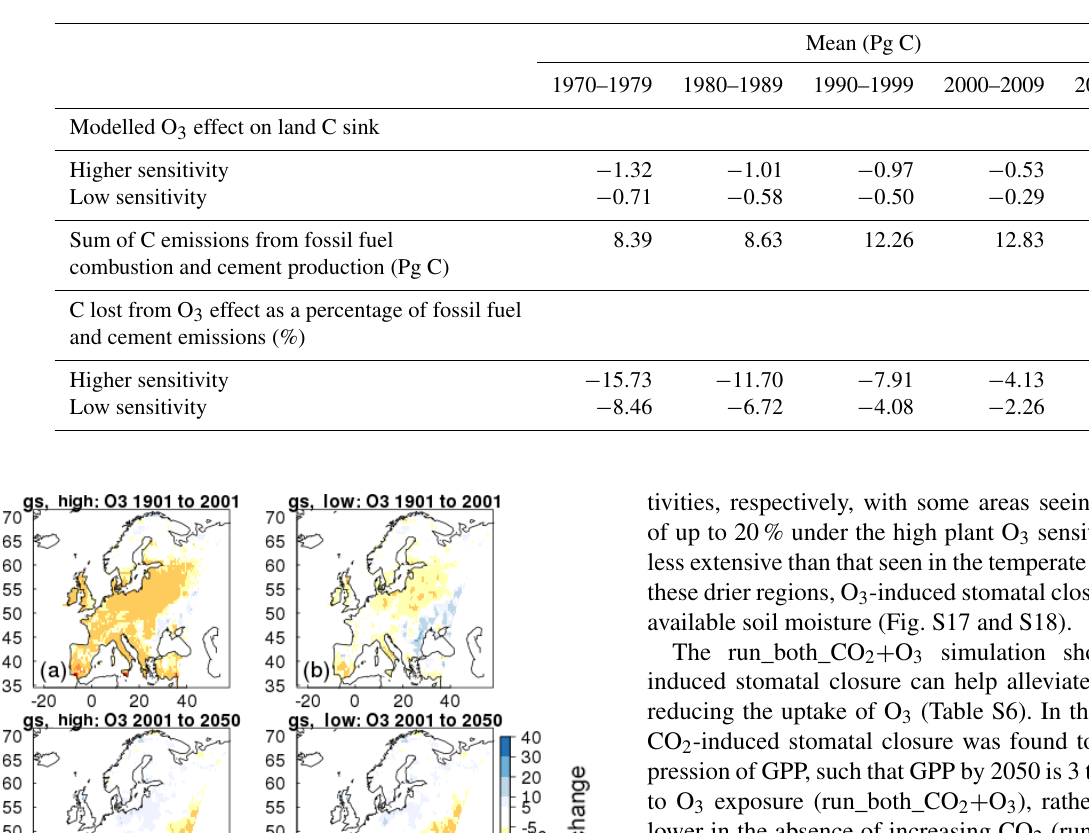
Table 2. Simulated change in total land carbon due to O 3 damage with changing atmospheric CO 2 concentration for the two vegetation sensitivities. The sum of carbon emissions for each decade from fossil fuel combustion and cement production for the EU28 plus Albania, Bosnia and Herzegovina, Iceland, Belarus, Serbia, Moldova, Norway, Turkey, Ukraine, Switzerland and Macedonia (EU28-plus) is shown; the data are from Boden et al. (2013). The simulated change in land carbon as a result of O 3 damage is depicted as a percentage of the EU28-plus emissions to demonstrate the magnitude of the additional source of carbon to the atmosphere from plant O 3 damage.